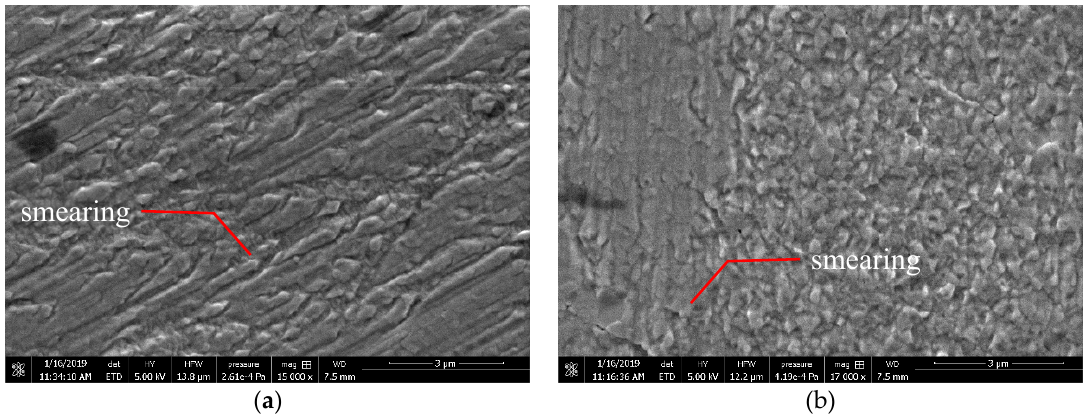
Figure 13. Wear trace on the AlTiN film: ( a ) SEM ‐ BSD and ( b ) SEM ‐ topo, 1000x and 2500x.